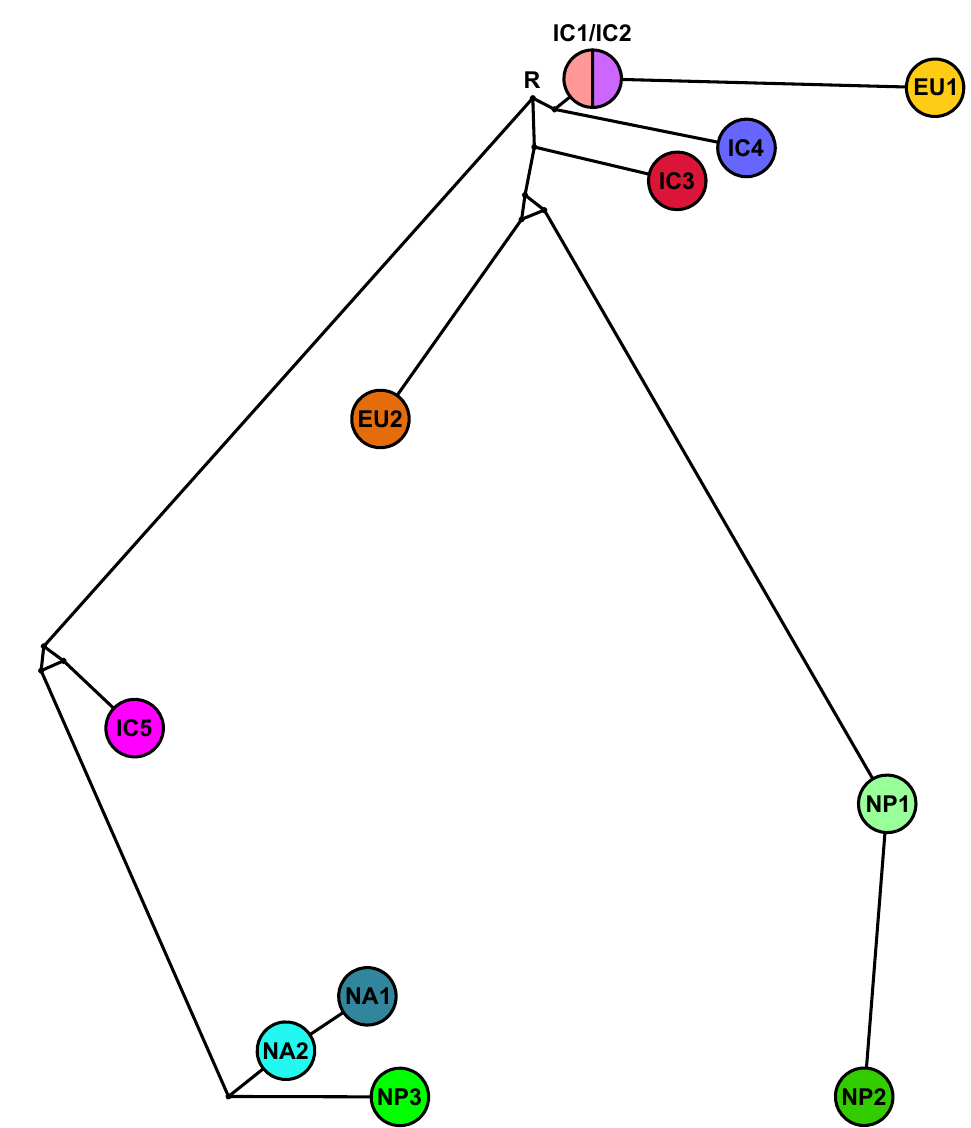
Figure 9. Median-joining network (MJN) with tolerance ε = 0 for the five Indochinese lineages (IC1-5), the three Japanese lineages (NP1-3) and the four known lineages (EU1, EU2, NA1 and NA2) of Phytophthora ramorum based on a seven-locus nuclear ( Avh120 , Avh121 , btub , gwEuk.30.30.1, hsp90 , ITS and trp1 ) dataset. The node with the highest number of connections and the most central position in this network and in the MJN with ε = 10 (Figure S5) was designated as root (R). Missing intermediates represent extant unsampled genotypes, extinct ancestors or “false-positives”. Branch lengths are proportional to the number of